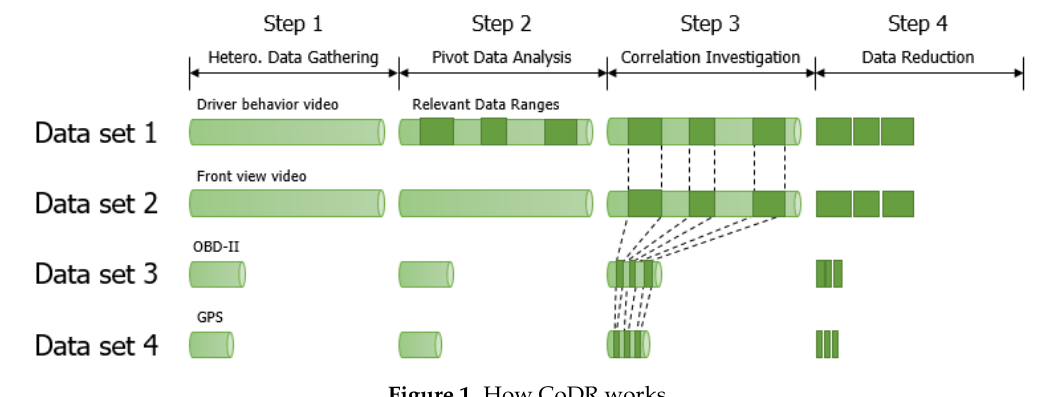
Figure 1. How CoDR